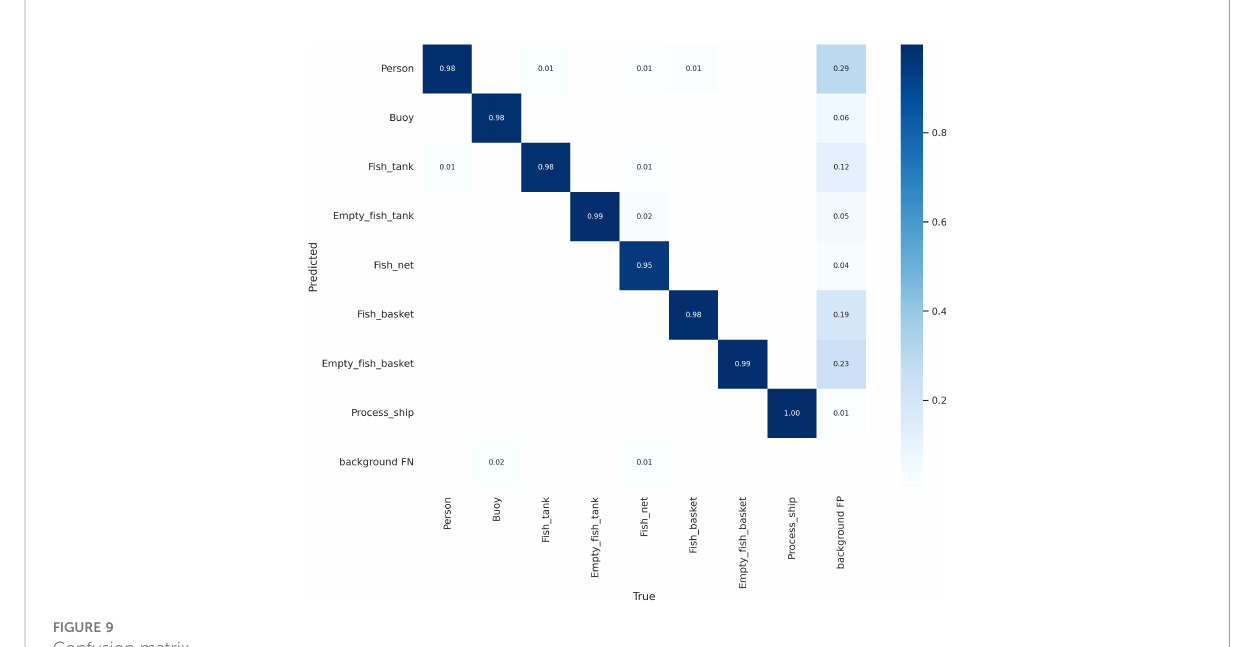
FIGURE 9 Confusion matrix.